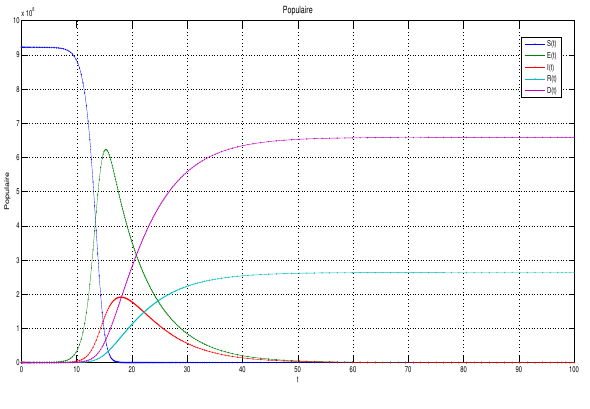
Figure 1. Evolution of